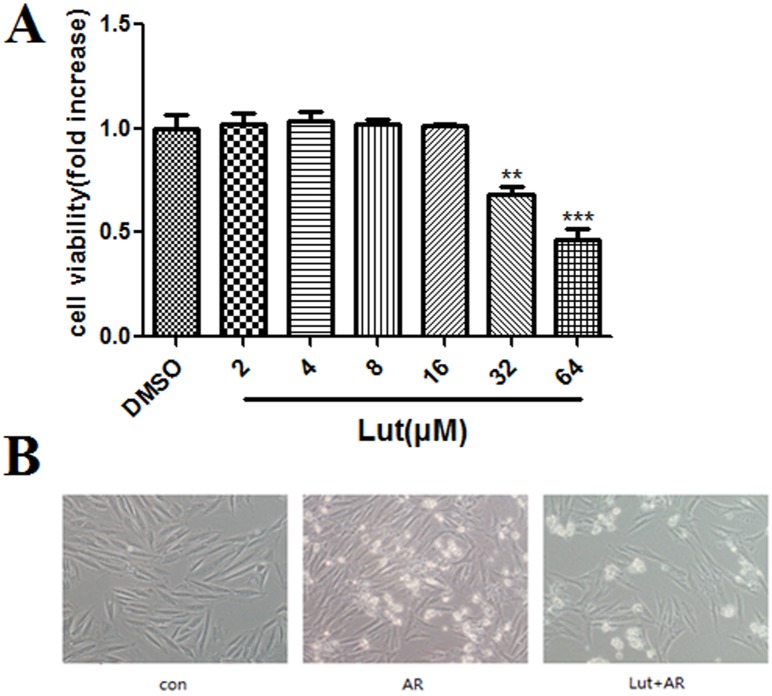
Cell viability by CCK-8 assay under LUT pretreatment and the morphology of H9c2 cells.A. CCK-8 assay detected the toxicity of LUT on H9c2 myocardiocytes. Compared to DMSO group, 32 and 64μM of LUT reduced the cell viability (**p<0.01, ***p<0.001), 16μM of LUT was chosen for the further experiments. B. The morphology of H9c2 cells in control, AR and LUT+AR group.